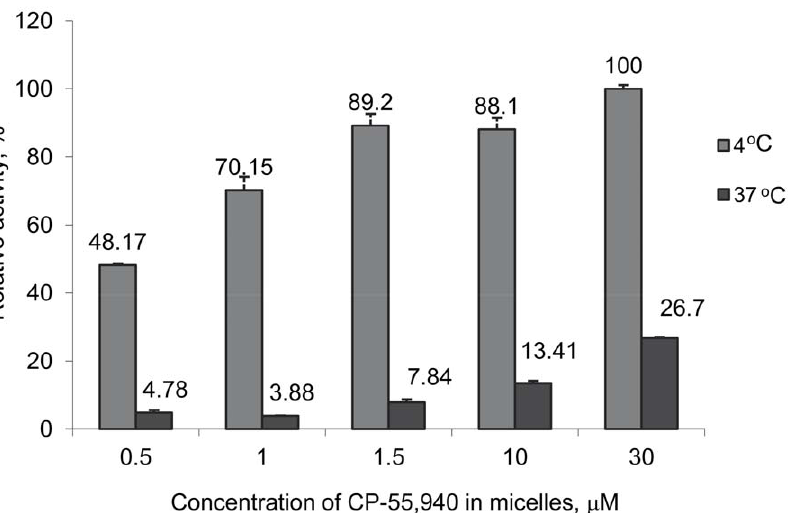
Figure 7. Effect of concentration of CP-55,940 on stability of CB 2 in micelles. CB 2 -130 dissolved at 1 m M concentration in DDM/CHAPS/CHS (0.1%/0.5%/0.1% w/v) micelles was incubated in the presence of CP-55,940 (at indicated concentrations) at either at 4 u C or 37 u C, reconstituted into liposomes and its functional activity analyzed as described in the text. The activity of protein recovered after incubation at 4 u C with 30 m M CP-55,940 is set to 100%. Each point represents an average of duplicate measurements 6 SD (error bars) of a representative proteoliposome preparation (n=2).